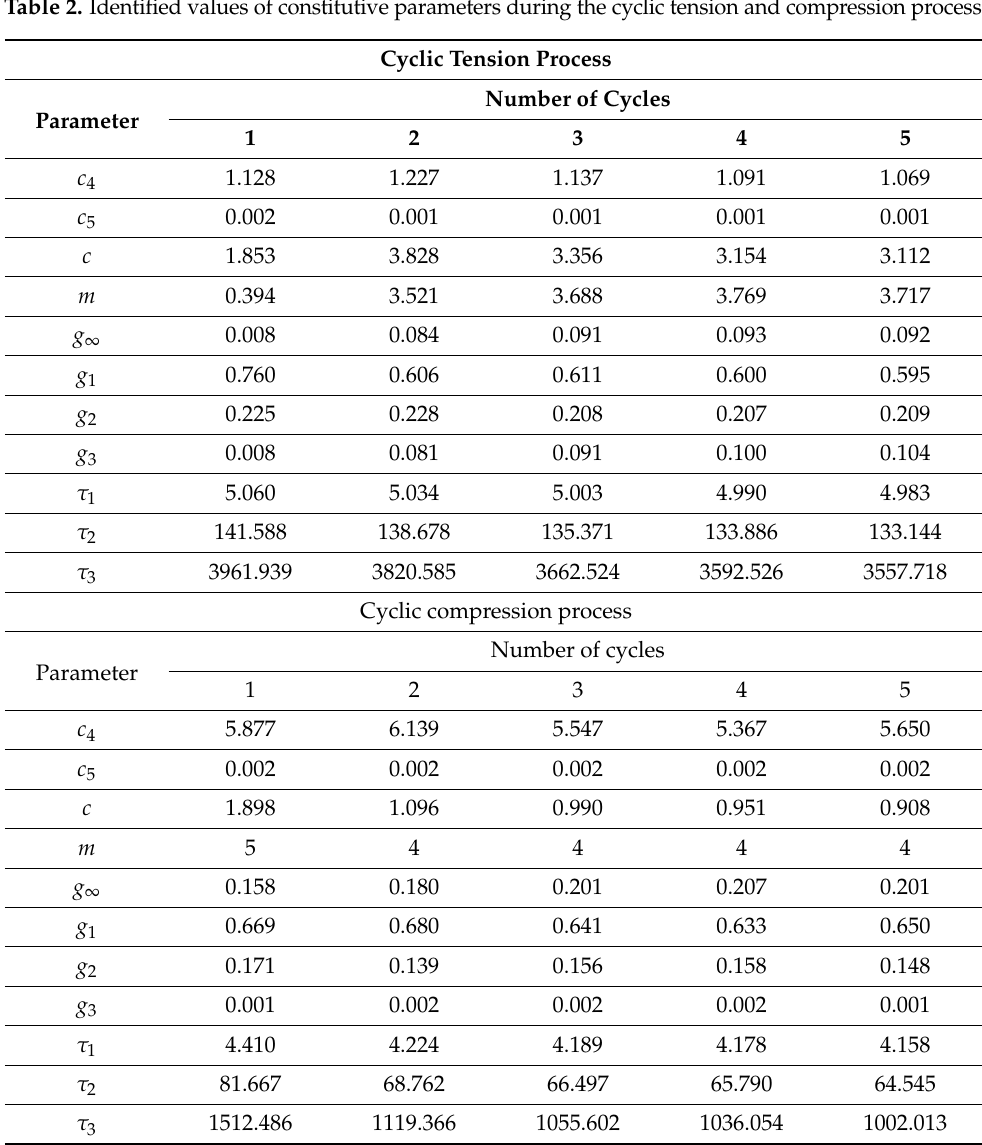
Table 2. Identified values of constitutive parameters during the cyclic tension and compression process.